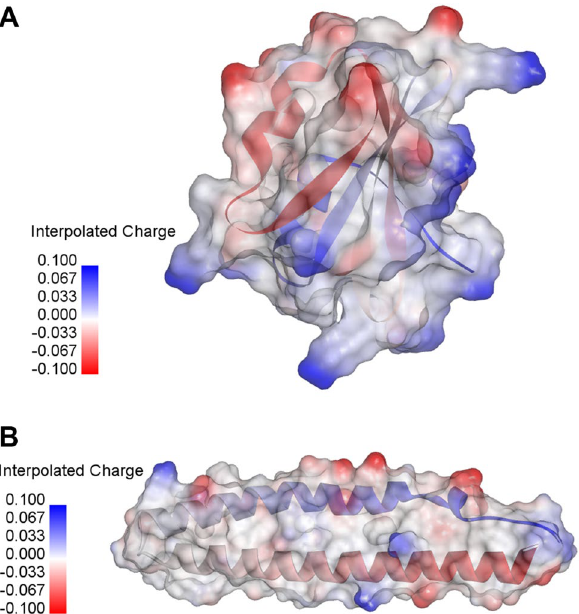
Figure 6. Interpolated charge surface of Q9YFR9 (TPP) and P0A223 (non-TPP) having TPP scores of 528.74 and 341.99, respectively, where the optimal threshold value is 418. Blue, white and red colors denote high, medium and low interpolated charge,